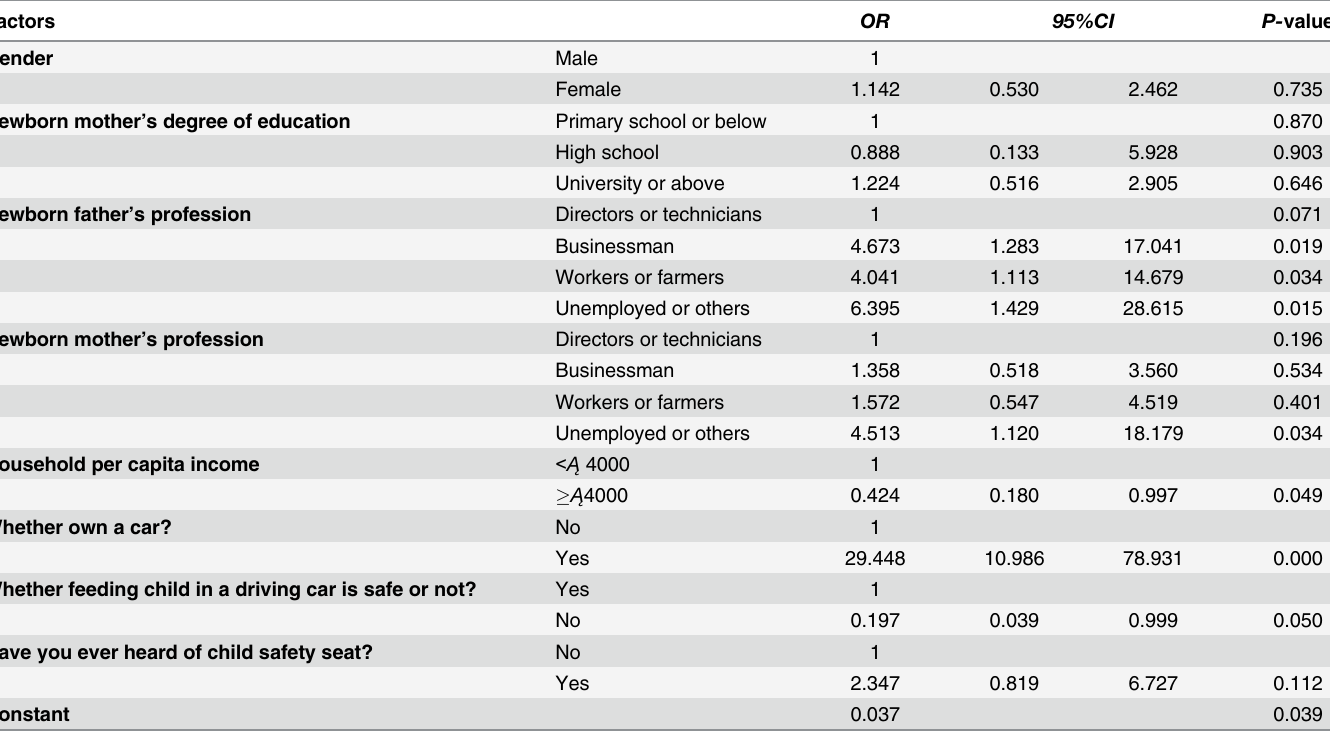
Table 3. Adjusted odds ratios of intended use of CSS among parents of newborn a